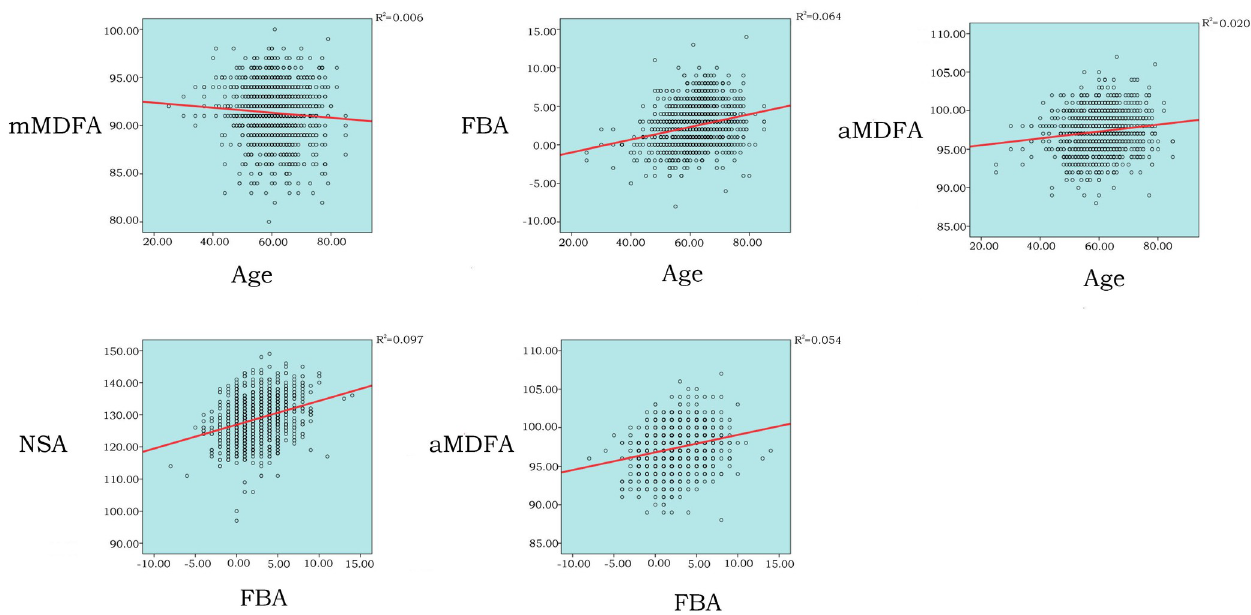
Fig 3. Relations between variables (Female). mMDFA: mechanical medial distal femoral angle; FBA: femoral bowing angle; NSA: neck-shaft angle; aMDFA: anatomic medial distal femoral angle.